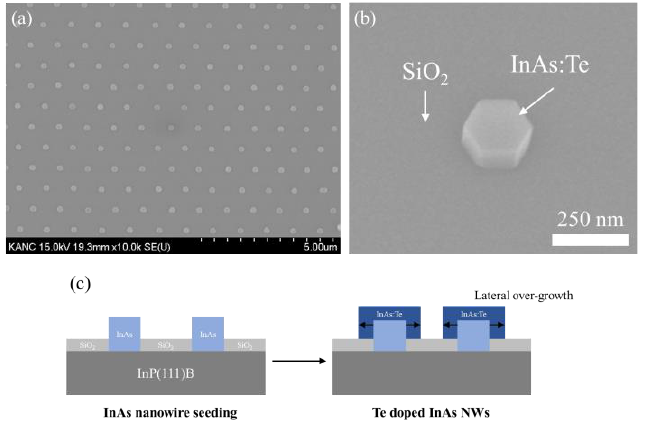
Figure 2. Tilted-view SEM images and high-resolution SEM images of ( a , b ) Te-doped InAs NWs with seed NWs under DETe gas flow (4.04 × 10 − 5 sccm); ( c ) schematic image of growth process of Te-doped InAs NWs with seed-layer InAs NWs.